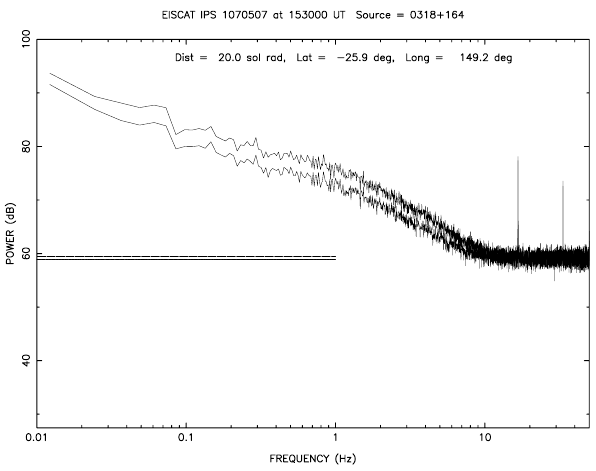
Fig. 2. Auto-power spectra of Tromsø data from an observation of the radio source J0318+164 taken on 5 May 2007. The plot with raised power levels in relation to the other includes data from an additional three channel boards in the VHF DSP. The horizontal dotted and dashed lines mark the background noise level for each spectrum. The power is given in decibels but is arbitrary in level; the frequency is displayed logarithmically.